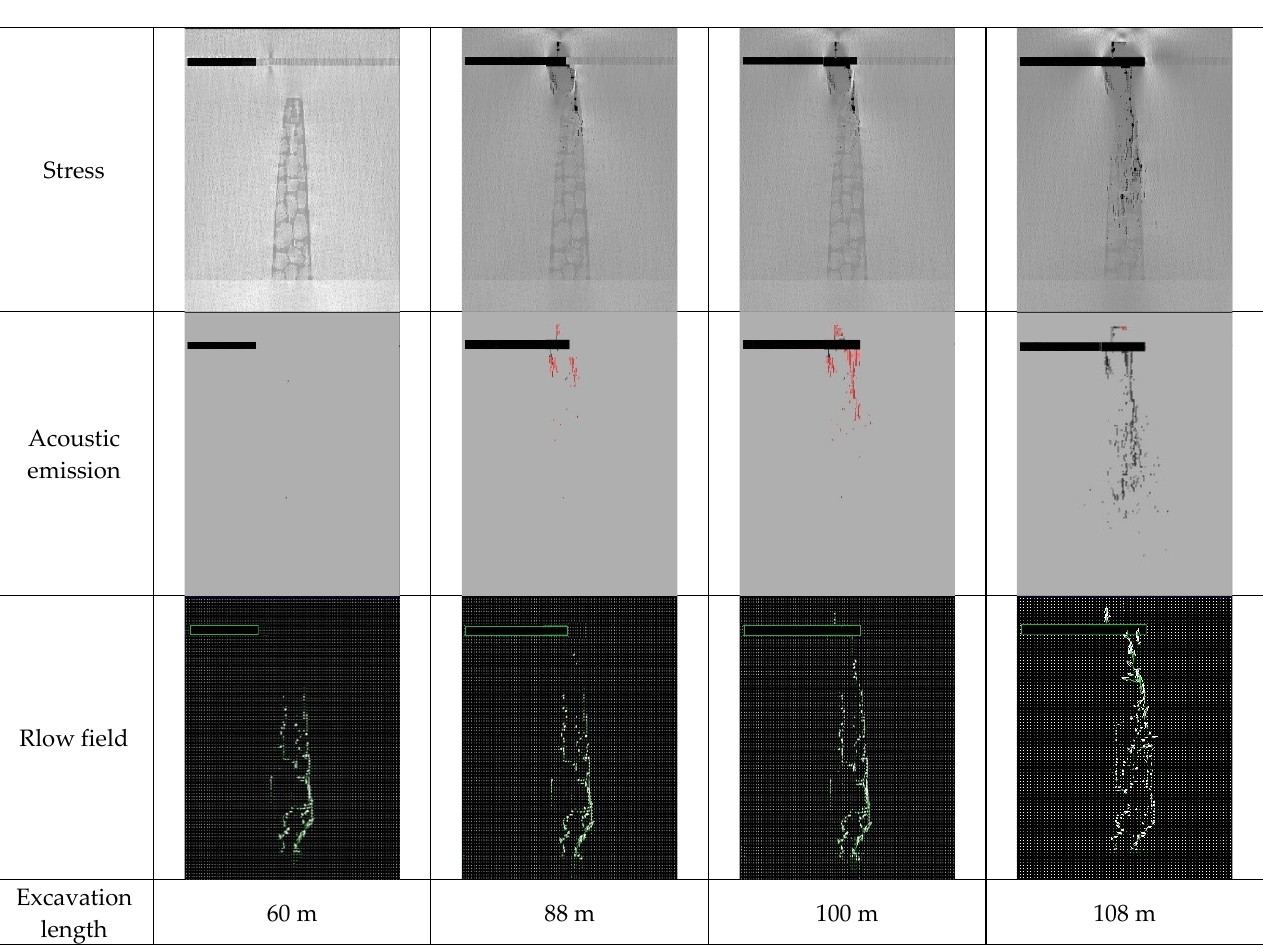
Figure 5. Numerical simulation results by RFPA during roadway